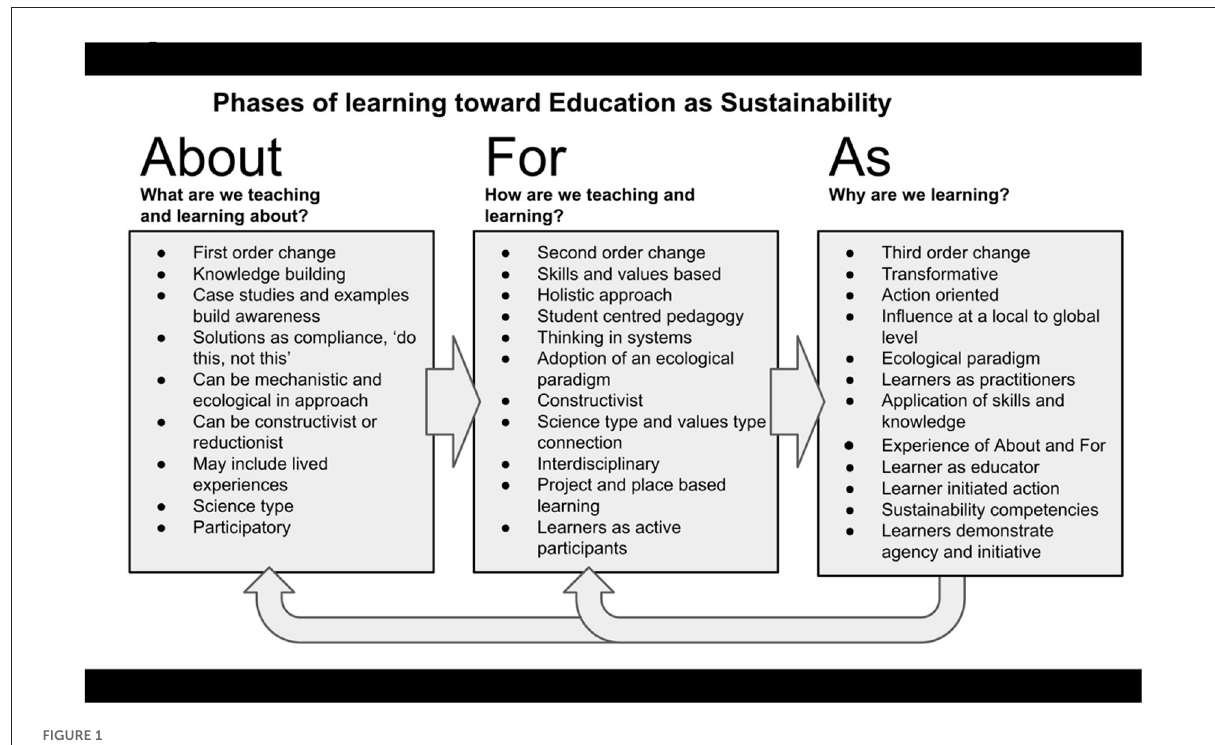
FIGURE1 Phases of learning toward education as sustainability.